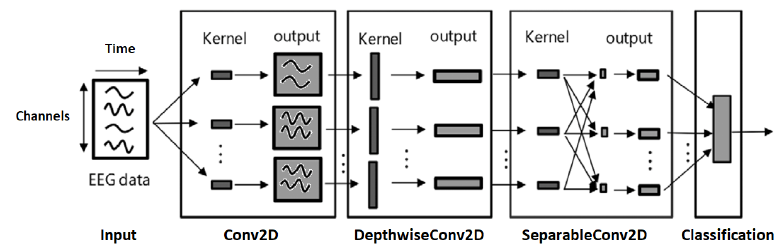
Figure 6. EEGNet model